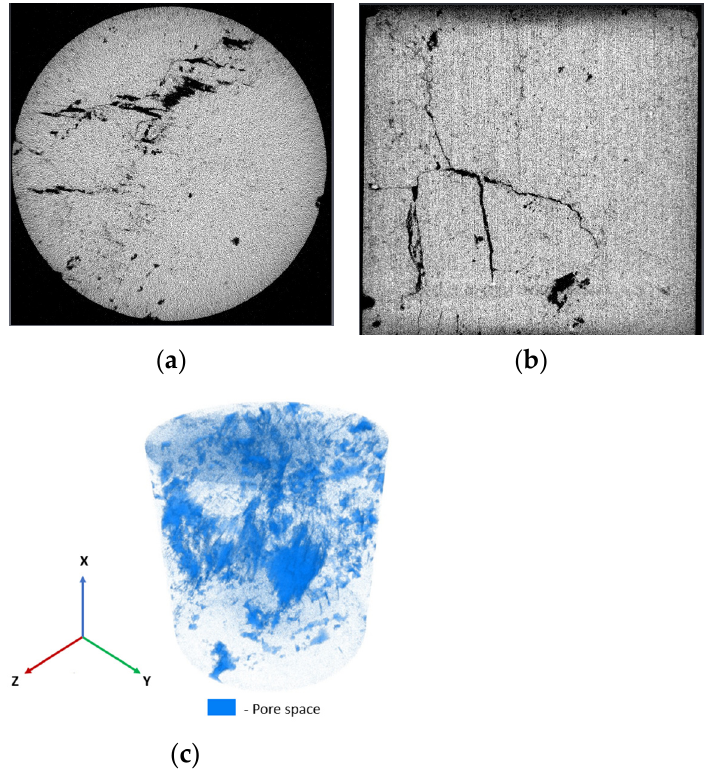
Figure 2. Results of x-ray tomography study of rock samples: ( a ) XY slice; ( b ) YZ slice; ( c ) 3D model of pore space.